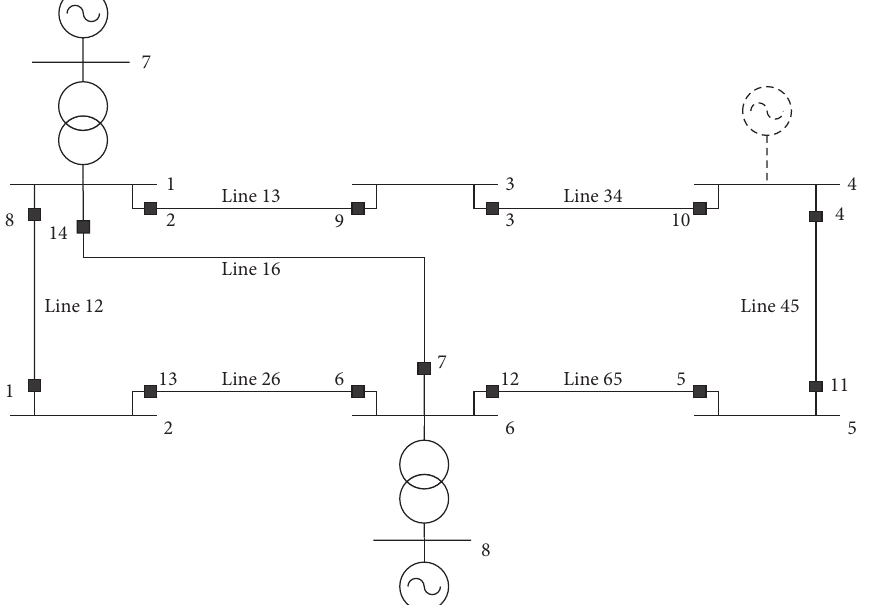
Figure 1: One-line diagram for an IEEE 8-bus test system.